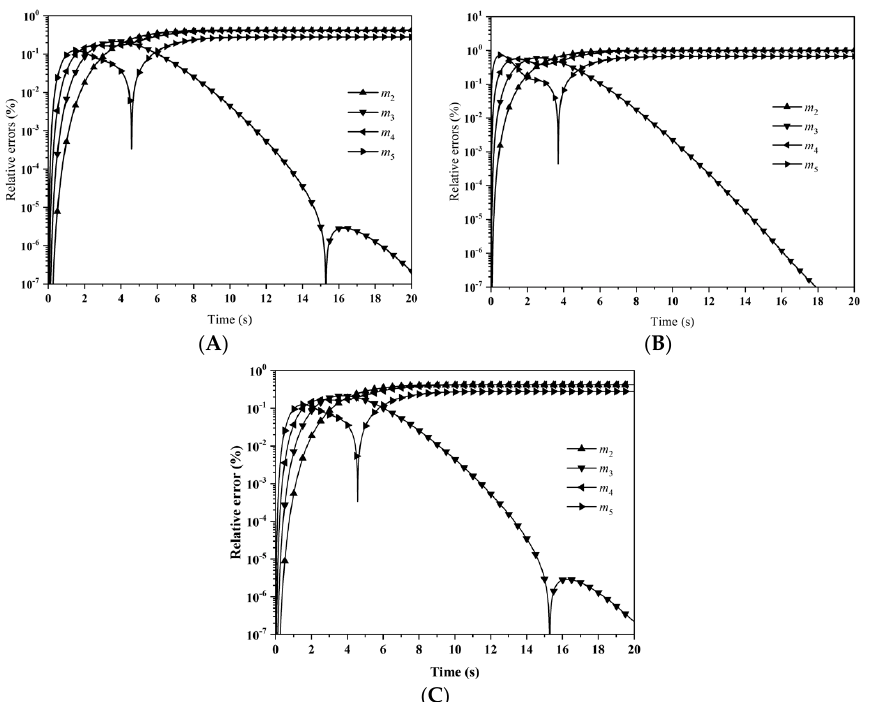
Figure 21. Evolutions for the relative errors of m 2 − m 5 for the aggregation and breakage combined process with constant aggregation kernel, linear breakage kernel, uniform daughter distribution, and Gaussian initial particle size distribution: ( A ) LFPQMOM; ( B ) QMOM; and ( C ) FPQMOM (up triangle: m 2 ; down triangle: m 3 ; left triangle: m 4 ; right triangle: m 5 ).